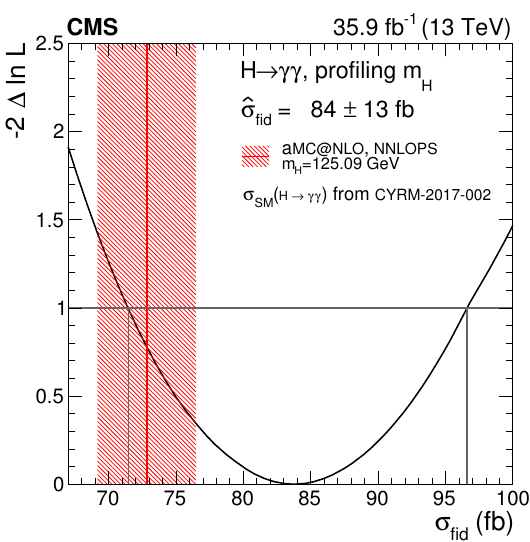
Figure 3 . Likelihood scan (black curve) for the (cid:12)ducial cross section measurement, where the value of the SM Higgs boson mass is pro(cid:12)led in the (cid:12)t. The measurement is compared to the theoretical prediction (vertical red line), shown with its uncertainty (red hatched area), and it is found in agreement within the